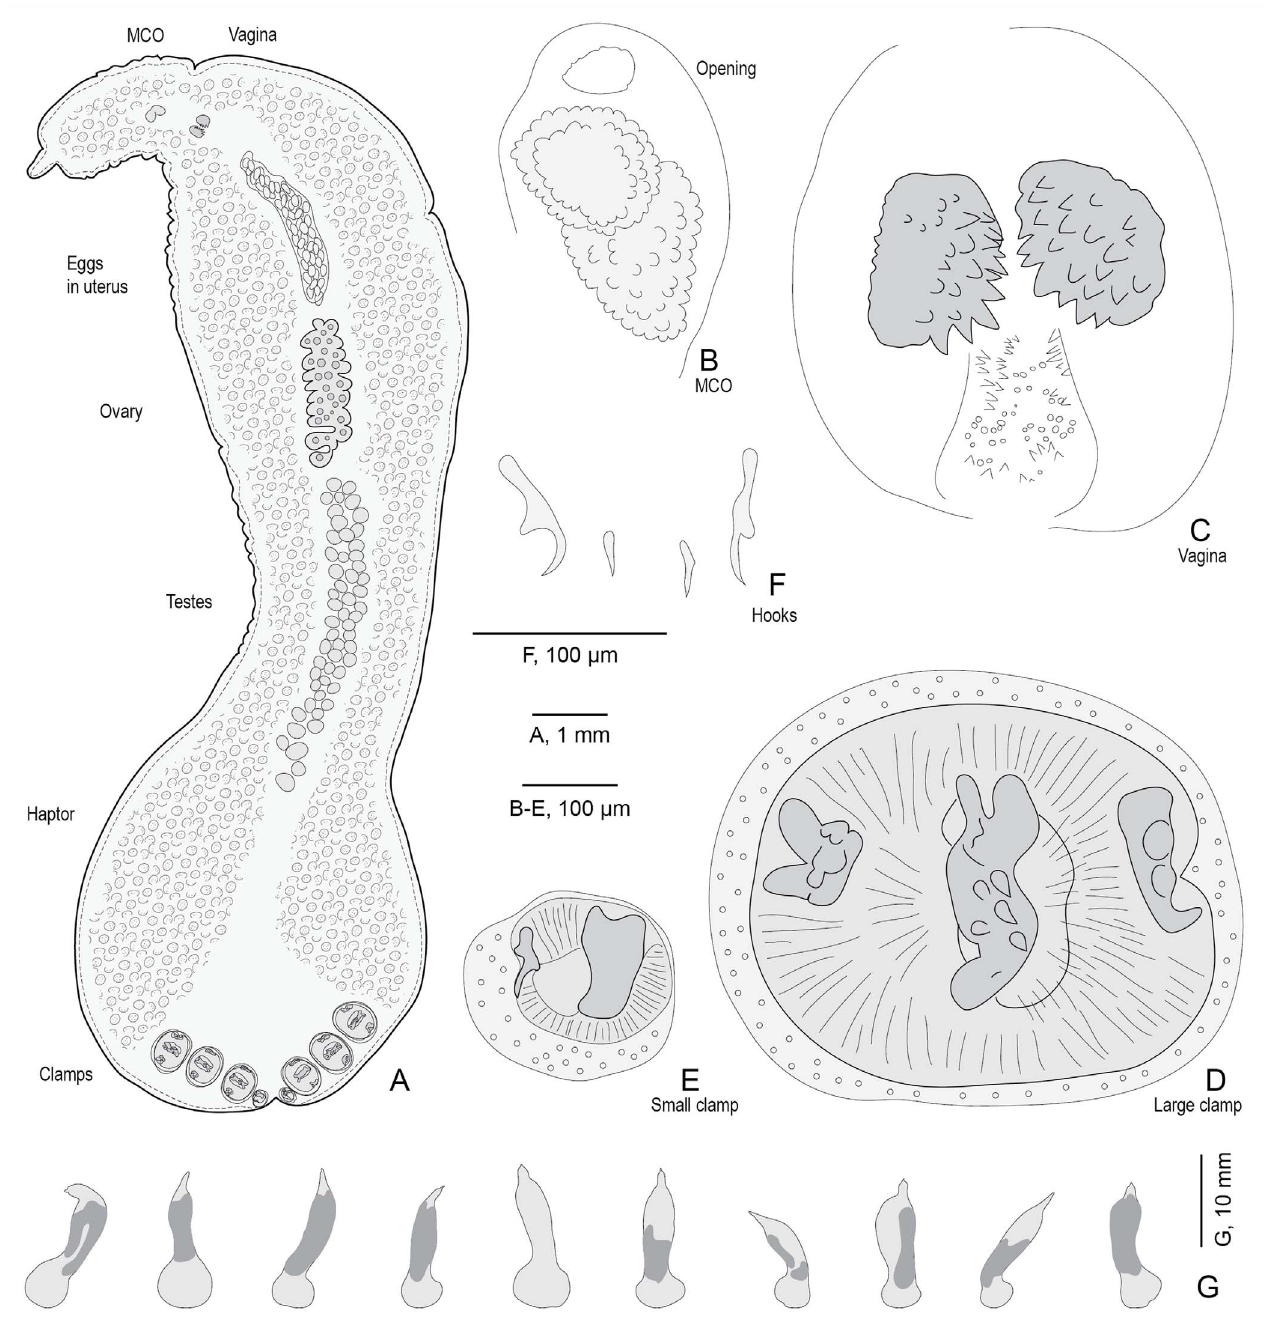
Figure 1. Drawings of specimens of Hexostoma thynni (Delaroche, 1811) Ra fi nesque, 1815 from Thunnus thynnus collected off Algeria. A, whole body; not all testes are fi gured; intestinal diverticula not fi gured, but colocalized with vitellarium. B, male copulatory organ. C, vagina. D, large clamp. E, small clamp. F, hooks. G, ten specimens on slides, showing only the silhouette and the dark zone within the body. A – F, slide MNHN HEL1806; G, slides MNHN